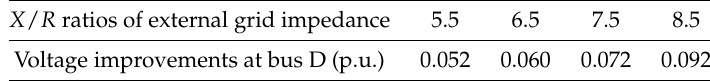
Table 1. Voltage improvements at bus D with different X / R ratios of external grid